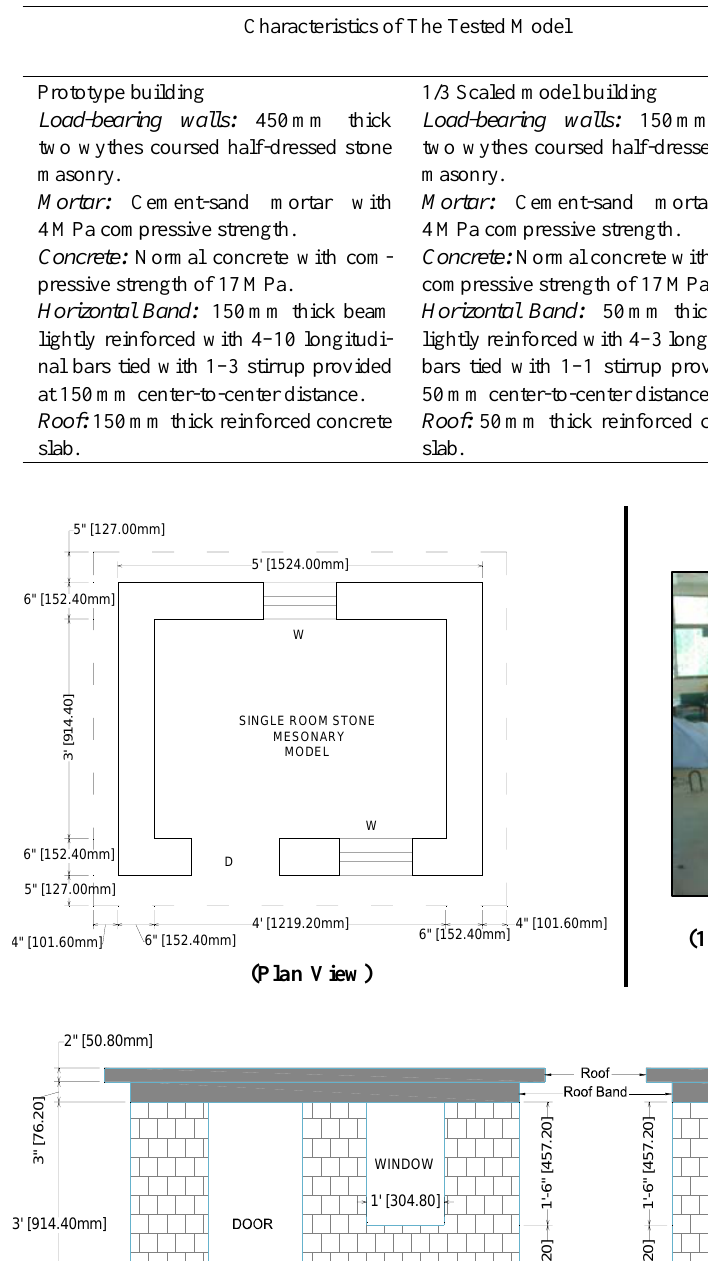
Table 1. Characteristics of the simple test model and similitude requirements for quantities conversion